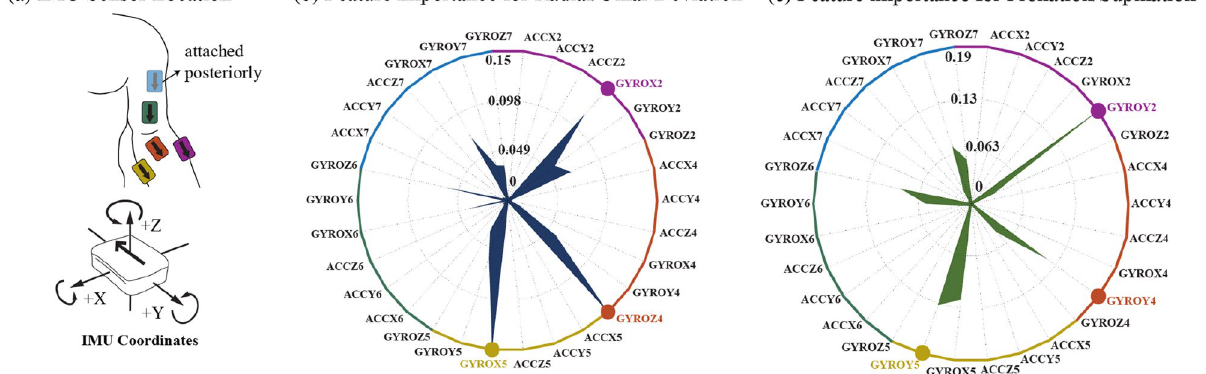
Figure 4. (a) IMU sensor locations on the upper limb. The faded sensor is attached on the posterior side of the upper limb. (b) Illustration of the important features contributing to predicting angular velocities for radial/ ulnar deviation of the wrist. (c) Illustration of the important features for pronation/supination. The solid circles in the outer rim indicate features with highest contribution towards prediction of angular